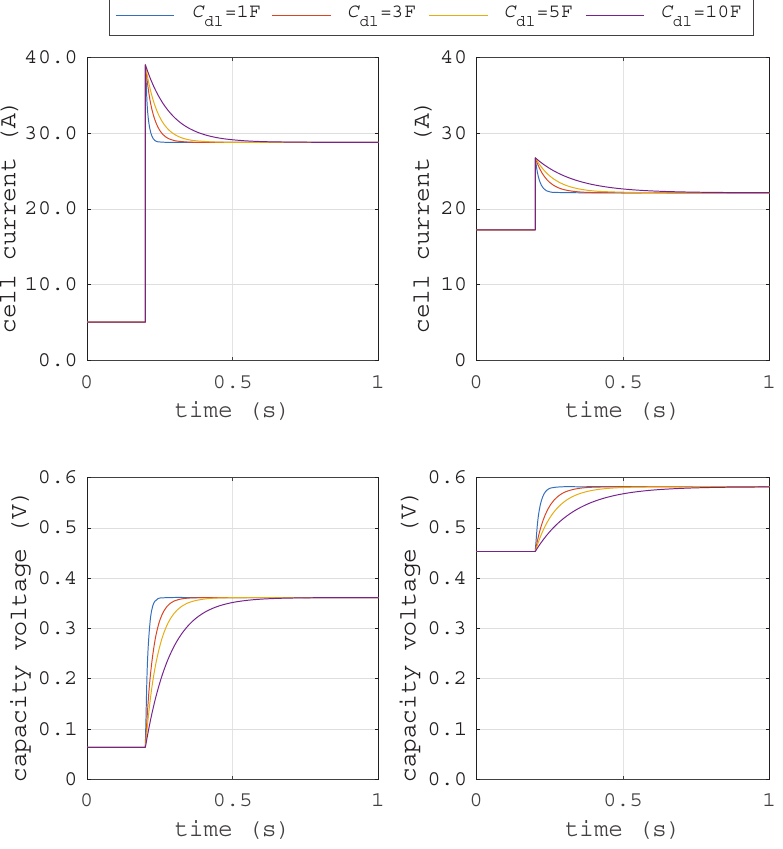
Figure 5. Time-current and time-voltage curves for different capacities: ( left ) at partial load operation; ( right ) at maximum power. Table 1. Simulation parameters. R act and R conc are calculated by the described